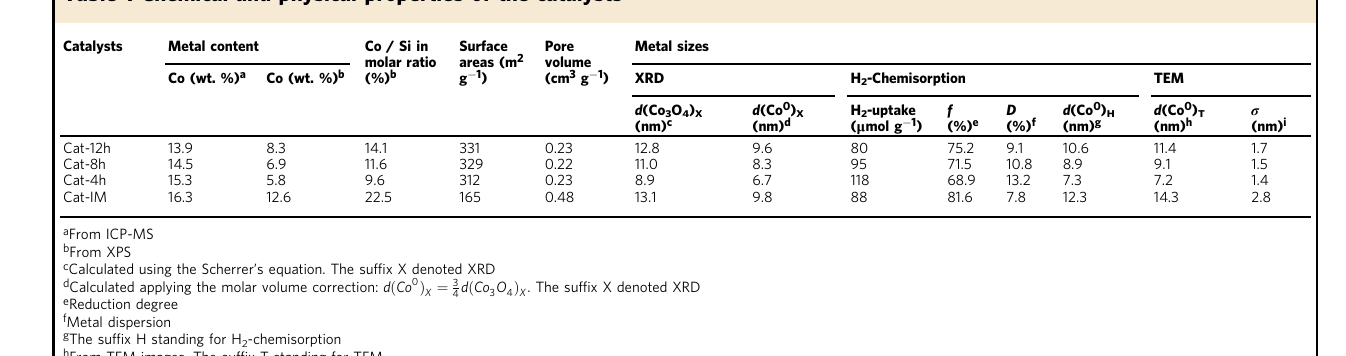
d ð Co O Þ X . The suf fi x X denoted XRD 3 4 4